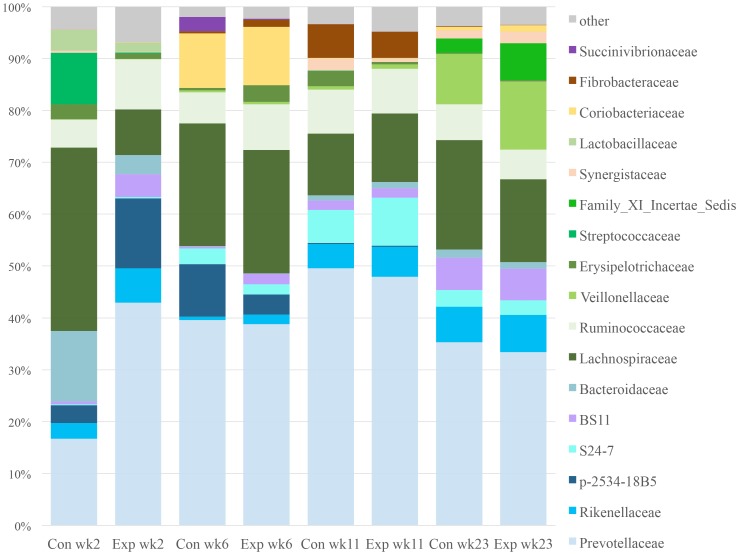
Effect of time and bacterial probiotic on the bacterial diversity at the family level of the lamb rumen over the first six months of life.X-axis labeled reflect treatment (Con = control, Exp = probiotic experimental), as well as sampling date.